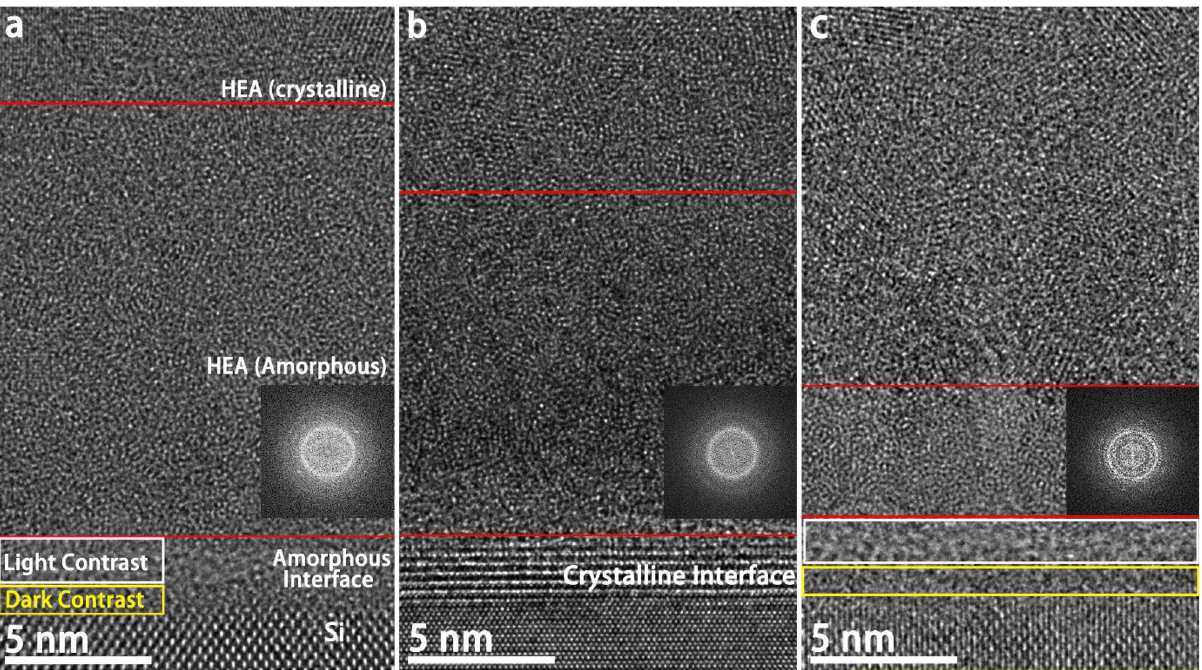
Figure 8. BF HRTEM of interface between Si and the HEA thin film. The insets are the Fast Fourier Transform (FFT) patterns from the region between the two red lines. ( a ) no substrate bias; ( b ) −50 V substrate bias; and ( c ) −100 V substrate